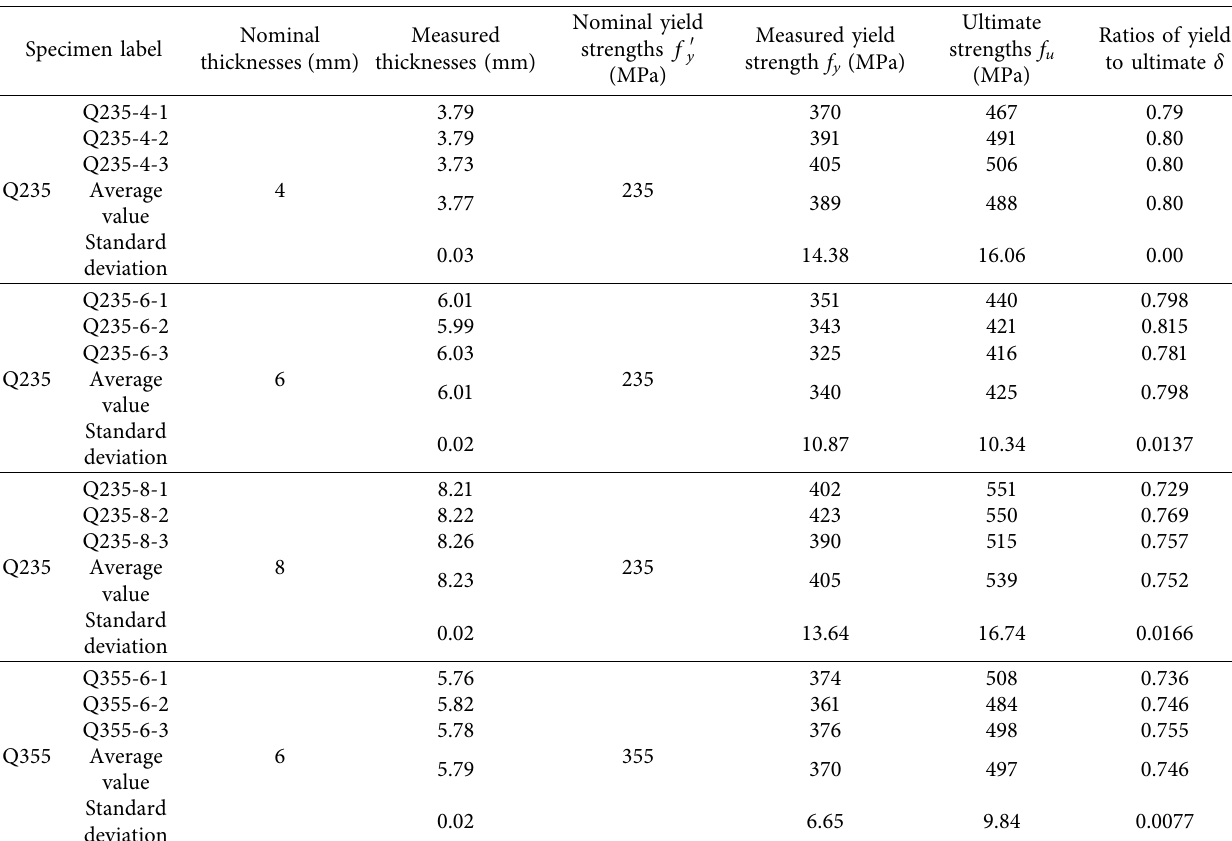
Figure 6: Details of material specimens. (a) Design dimension. (b) Loading device. (c) Fracture Table 3: Test results of material specimens.